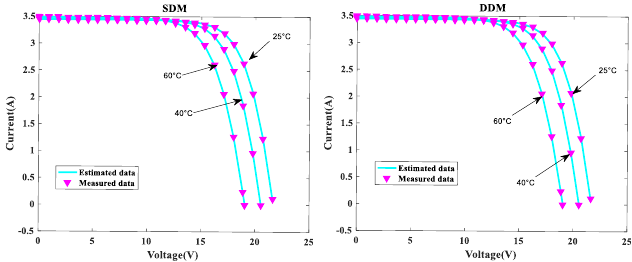
Figure 11. I-V for KC200GT at various temperatures.